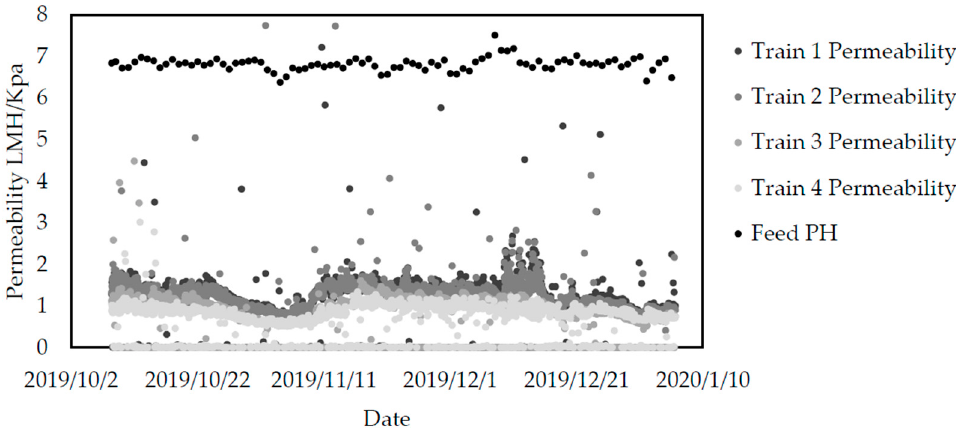
Figure 4. Permeability trend of the ultrafiltration membrane within three months after the renovation.